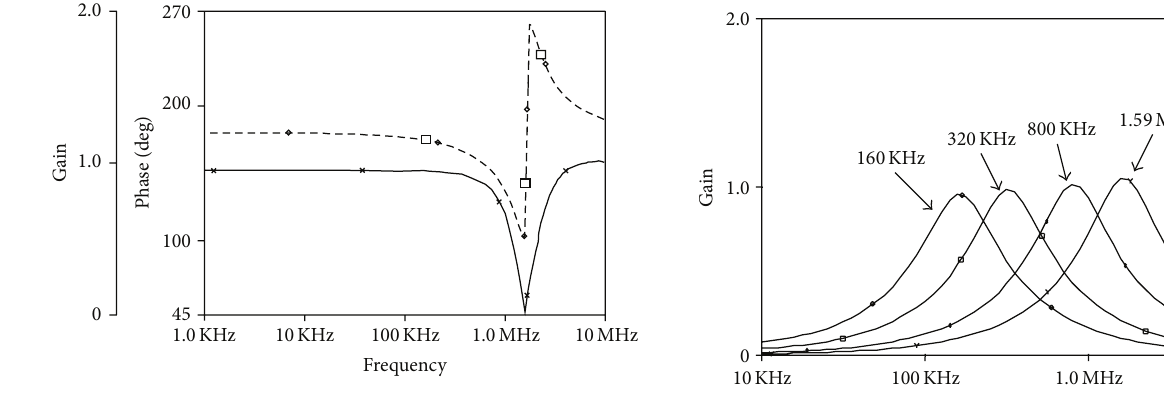
Figure 7: Magnitude and phase plot for notch response.